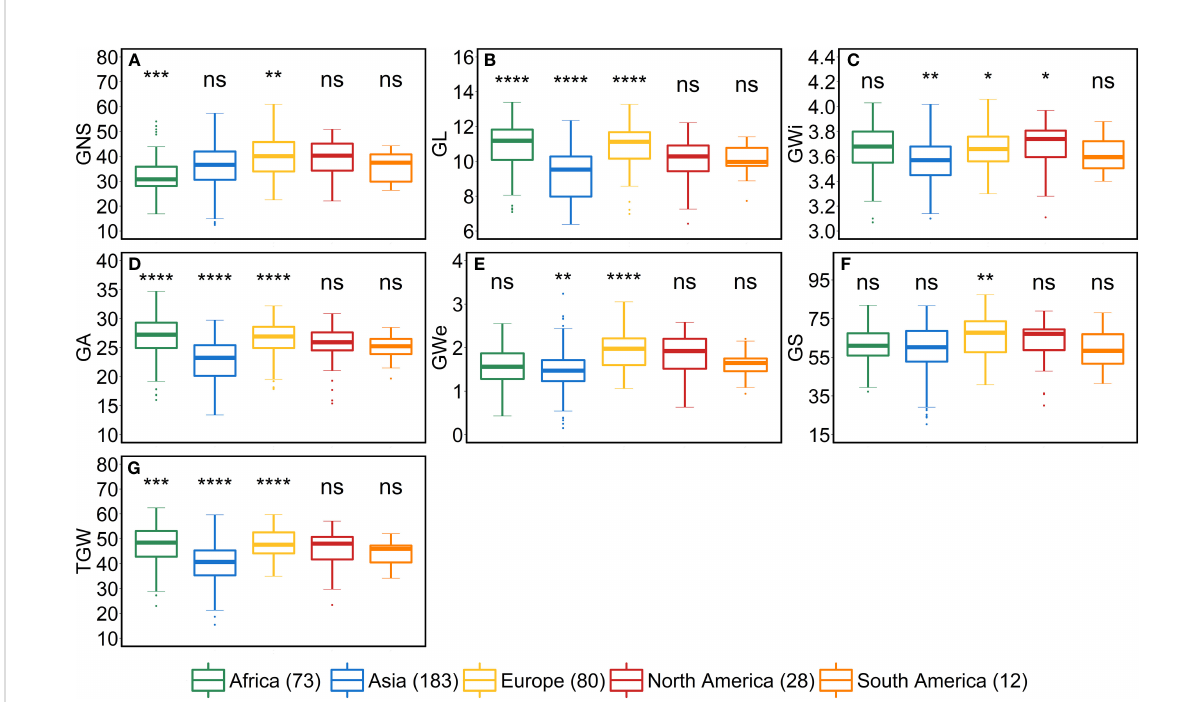
FIGURE 6 Comparison of accessions according to their geographical origin for the grain traits. (A) grain number per spike (GNS), (B) grain length (GL in mm), (C) grain width (GWi in mm), (D) grain area (GA in mm 2 ), (E) grain weight per spike (GWe in g), (F) grain set (GS in %) and (G) thousand- grain weight (TGW in g). ‘ n ’ denotes the number of accessions in this panel and the number of the accessions belonging to each continent; ****, ***, **, and * = signi fi cance level at the 0.0001, 0.001, 0.01, and 0.05 probability level, respectively and ‘ ns ’ represents insigni fi cant differences and the legend represents different continents.